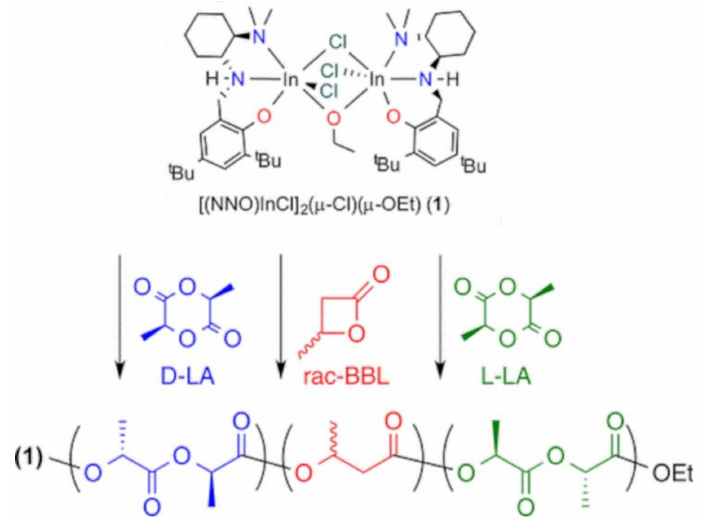
Figure 10. Formation of triblock PLA by sequential addition of LA. Obtained from reference [148]. Copyright @ 2013